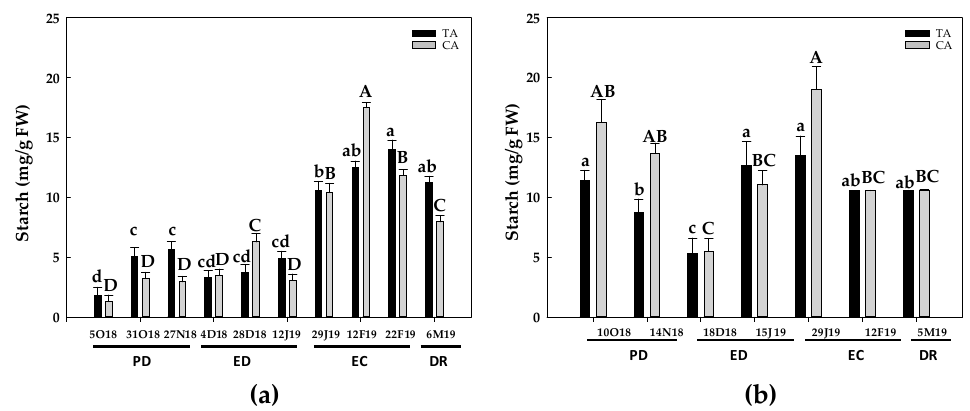
Figure 2. Evolution of starch contents in flower buds from peach ‘GEM020’ cultivated in two different geographical areas during the dormancy cycle on two different seasons. ( a ): season 1 (2017–2018); ( b ): season 2 (2018–2019). Data represent the mean ± SE, n = 5. Different letters (lowercase and uppercase for the samples of the temperate (TA) and the cold area (CA), respectively) indicate significant differences according to the Tukey’s multiple test ( p ≤ 0.05). PD: paradormancy; ED: endodormancy; EC: ecodormancy; DR: dormancy release. FW: fresh weight. The chill units accumulated at the different times and locations are shown in Supplemental file 1.